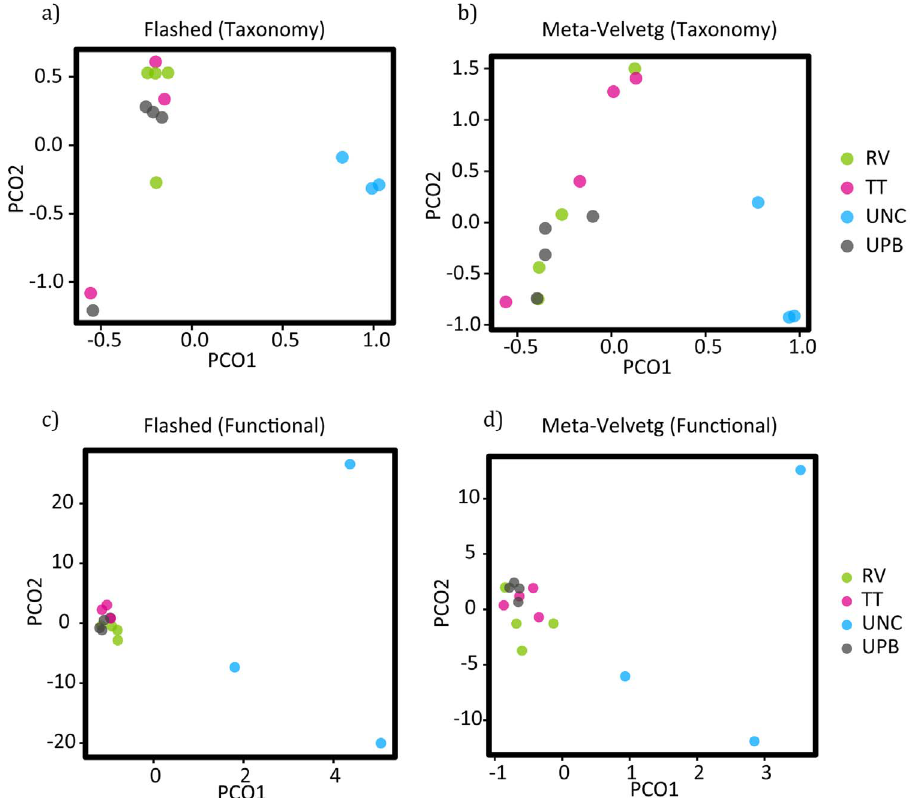
Figure 2. Principal Coordinates Analysis (PCoA) depicting the taxonomic (a and b) and functional (c and d) differences among the replicates and treatments.